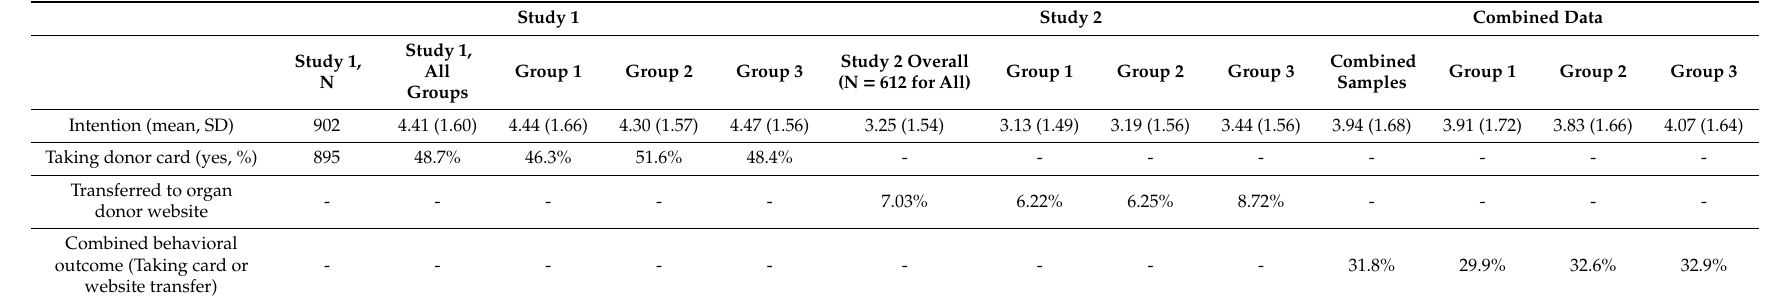
Table 2. Summary of outcomes (intention and taking card / website transfer).